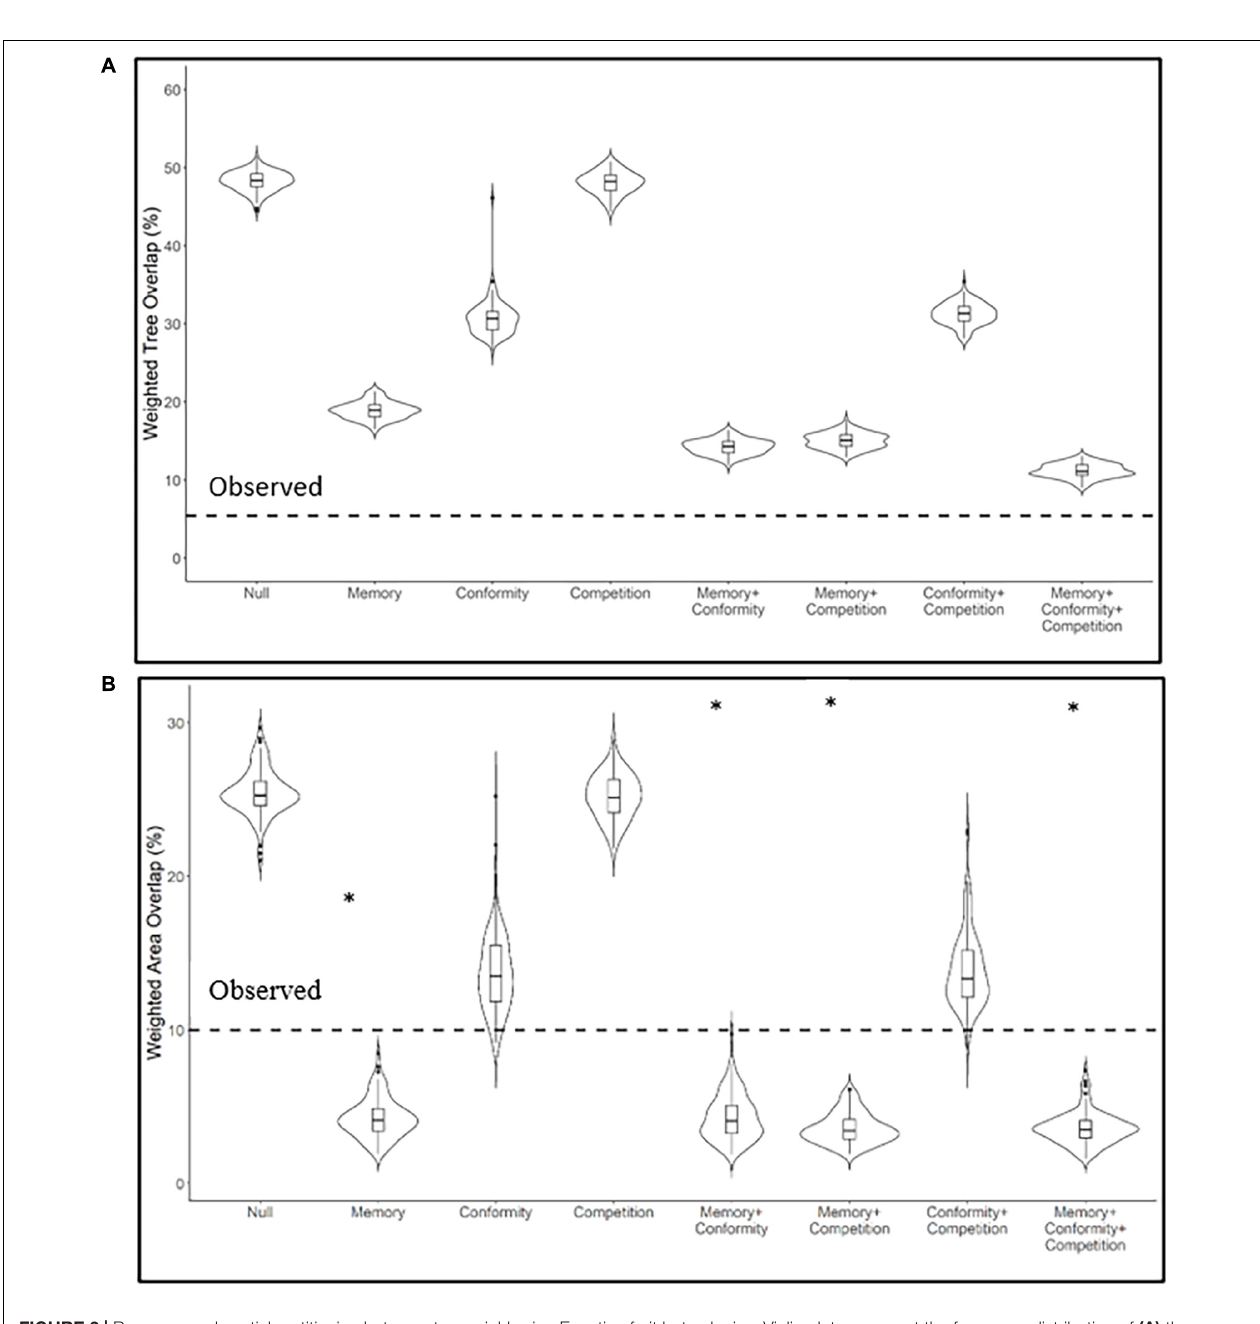
FIGURE 3 | Resource and spatial partitioning between two neighboring Egyptian fruit bat colonies. Violin plots represent the frequency distribution of (A) the weighted tree overlap (WTO, range: 9–51%) and (B) weighted area overlap (WAO, 75% KUDs, range: 0–31%) after 100 iterations of agent-based models for observed coefficients of memory and conformity, density-dependent competition, and their interactions. The dashed line represents the observed values of tree and area overlap. ∗ p -value ≥ 0.05 comparing simulated and